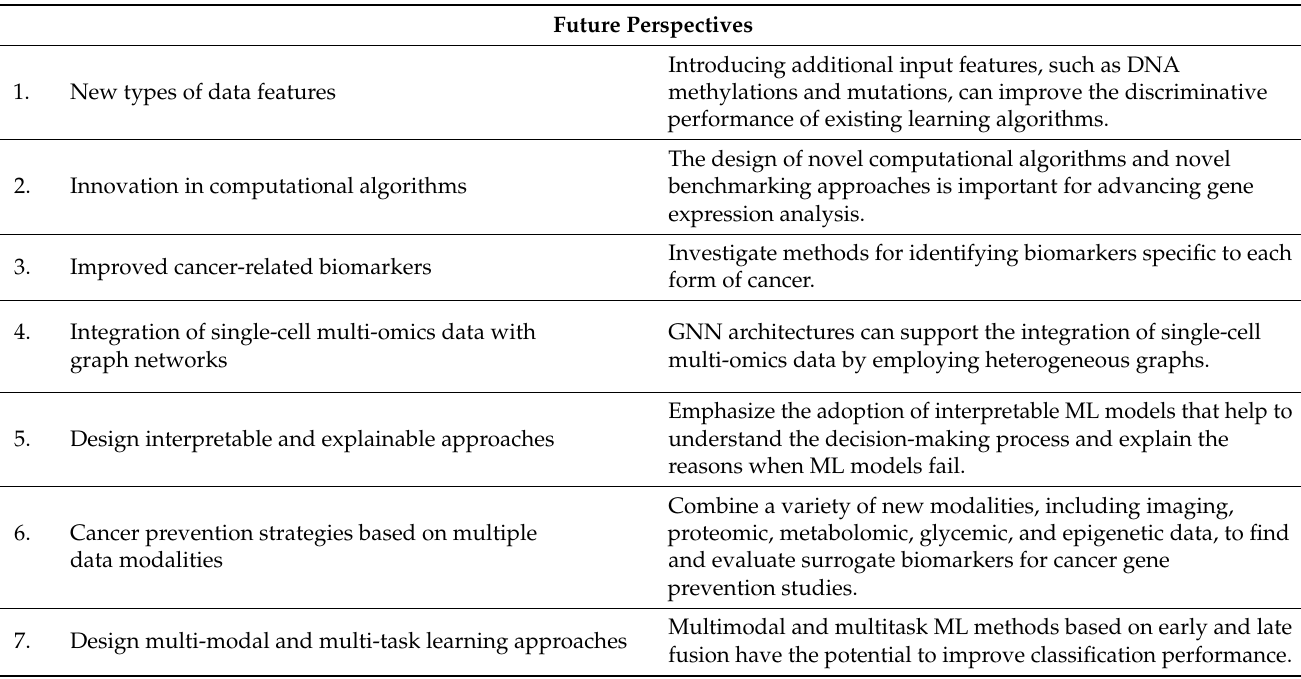
Table 11. Future directions in ML-based methods using gene expression